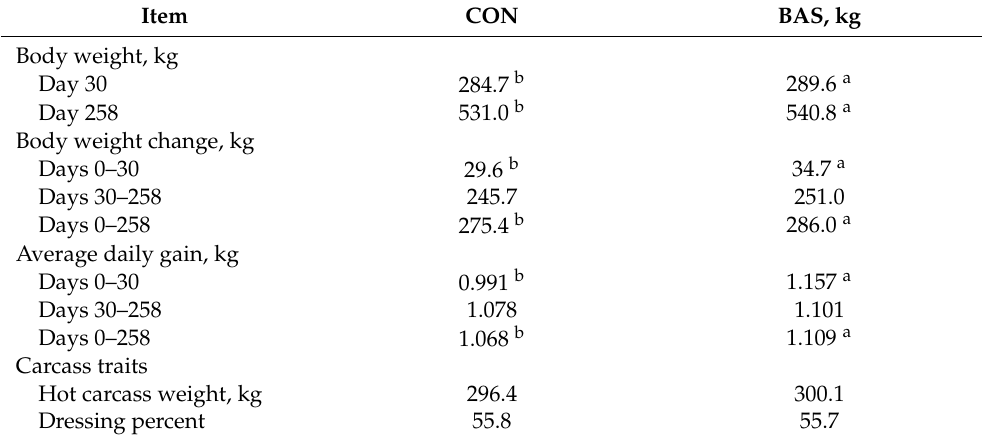
Table 5. Performance of crossbred beef steers receiving (BAS; n = 195) or not (CON; n = 195) a bovine appeasing substance at castration (day 0) 1